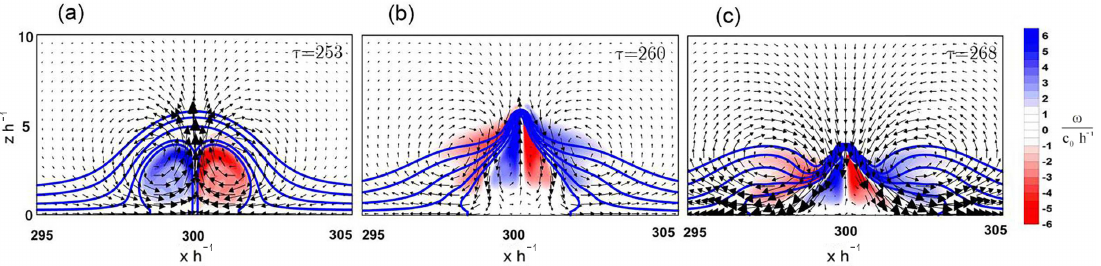
Figure 7. Details of the interaction of waves of equal amplitude α = 3 . 3 at different times (case (A9; A9)) in a 2-D setting. The velocity, vorticity ω , and isopycnals are